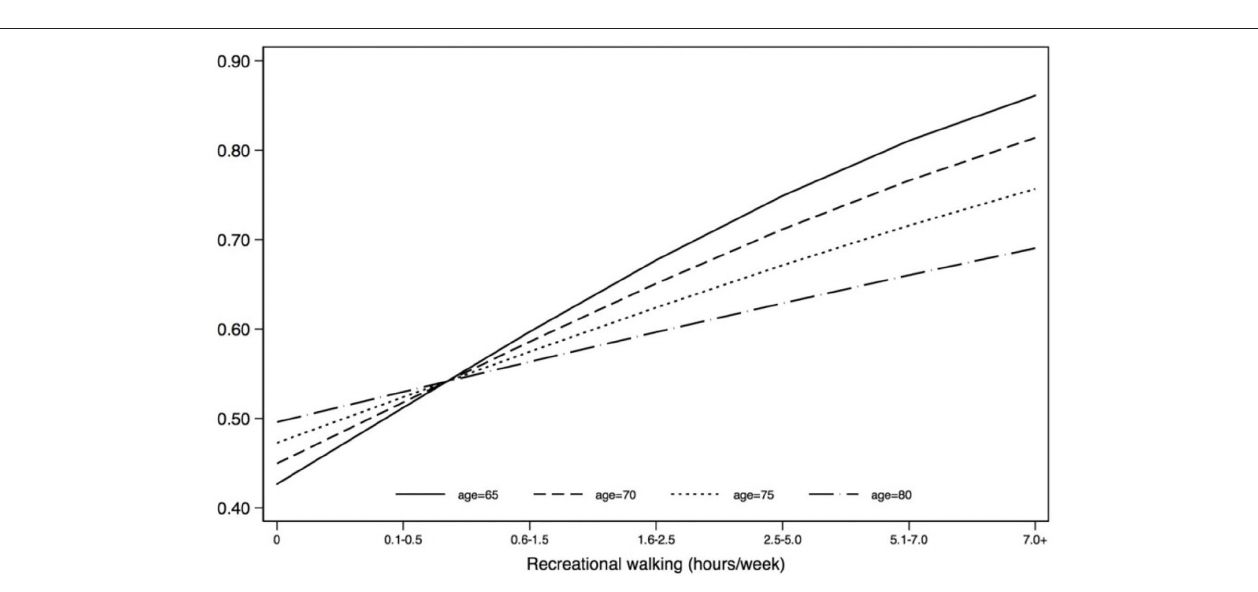
FIGURE 2 | Moderating effect of age: predicted probability of becoming a utilitarian walker by age and recreational walking (older adult model). Age (OR = 1.025, p = 0.360, 95% CI = 0.972–1.080); recreational walking (OR = 1.348, p < 0.001, 95% CI = 1.197–1.518); age*recreational walking (OR = 0.982, p = 0.029, 95% CI =